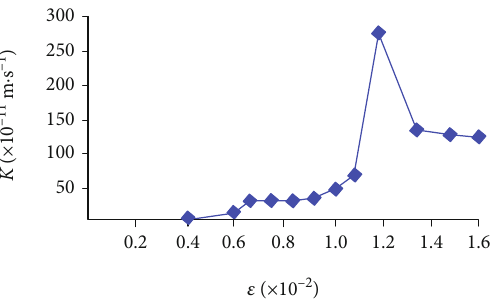
Figure 6: Variation curve of the permeability coe ffi cient K with strain ε